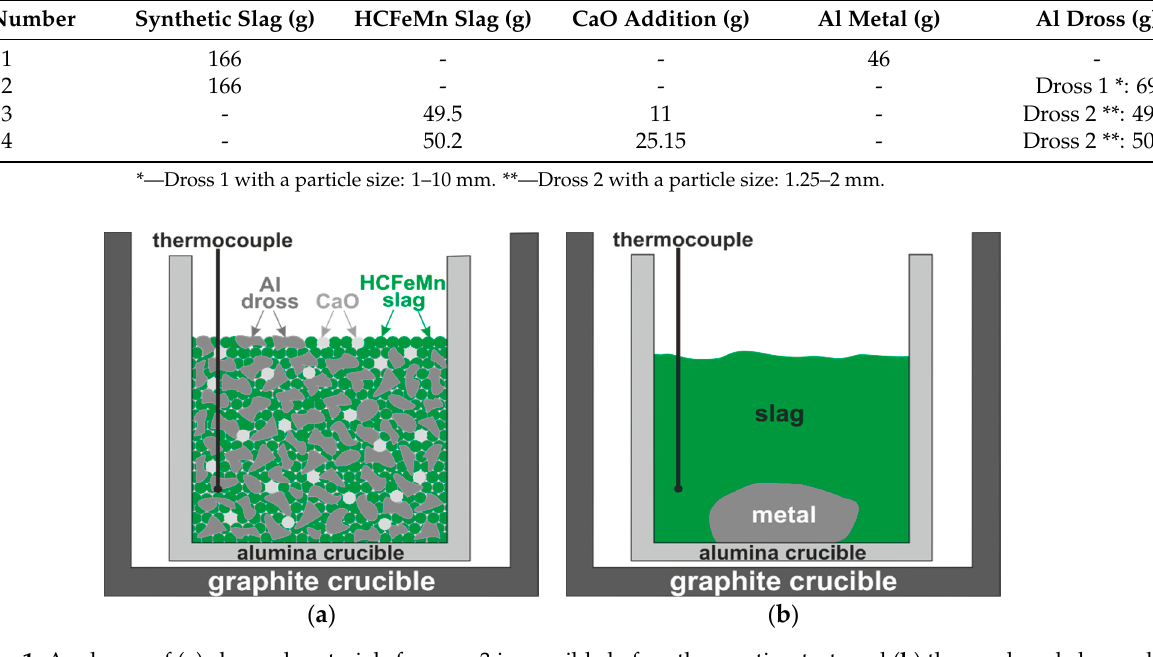
Figure 1. A scheme of ( a ) charged materials for exp. 3 in crucible before the reaction test, and ( b ) the produced slag and metal after reactions.